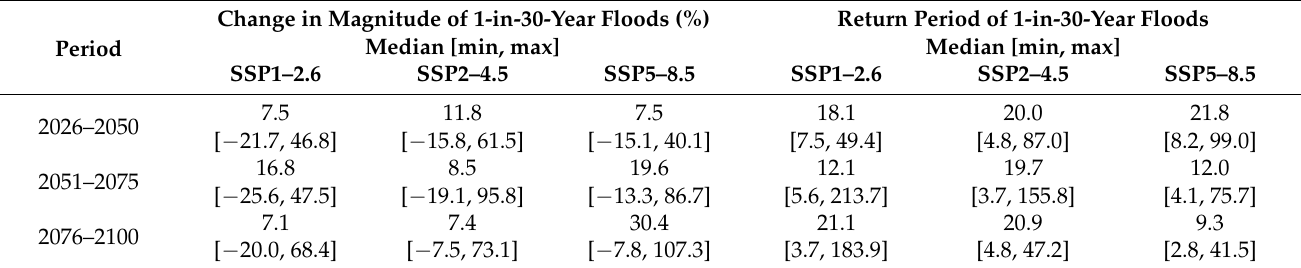
Figure 5. Projected magnitude and return period of 1-in-30-year floods for the near-, mid-, and long-term periods under the SSP1–2.6 (SR1), SSP2–4.5 (SR2), and SSP5–8.5 (SR3) scenarios. Table 6. Magnitude and return period of 1-in-30-year floods for the near-, mid-, and long-term periods under the SSP1–2.6, SSP2–4.5, and SSP5–8.5